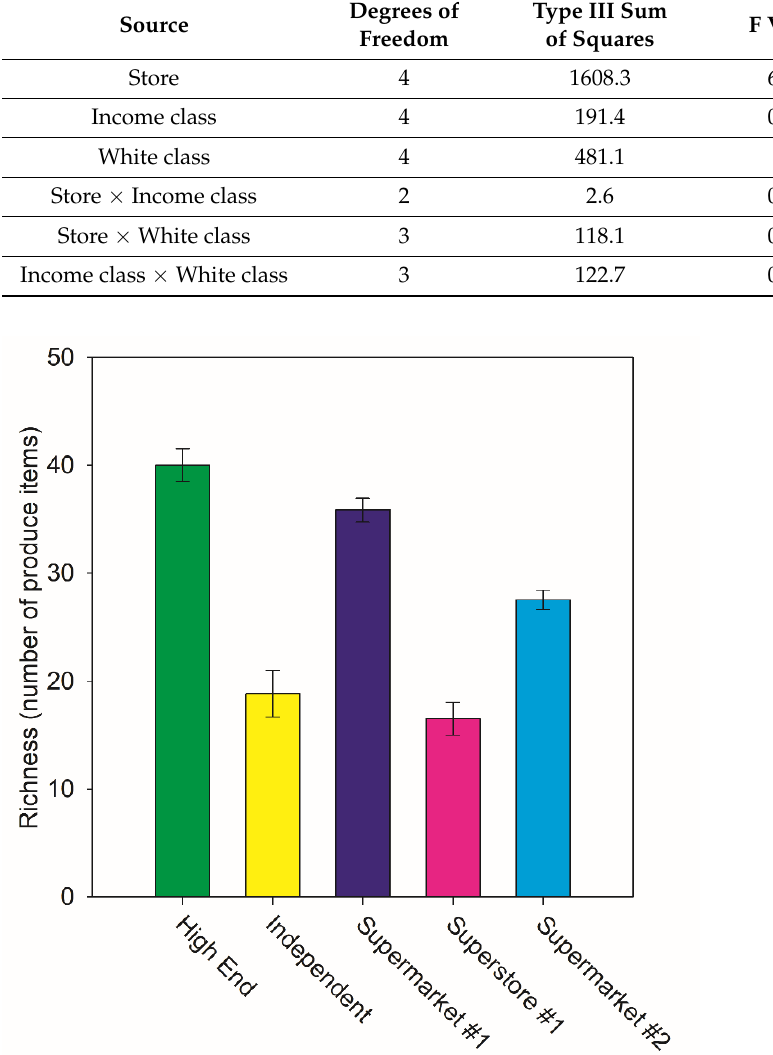
Table 1. Results from ANOVA (N = 39) performed using a General Linear Model (proc GLM, SAS 9.4, SAS Institute, Cary, NC, USA). The “*” indicates results significant at p < 0.05.